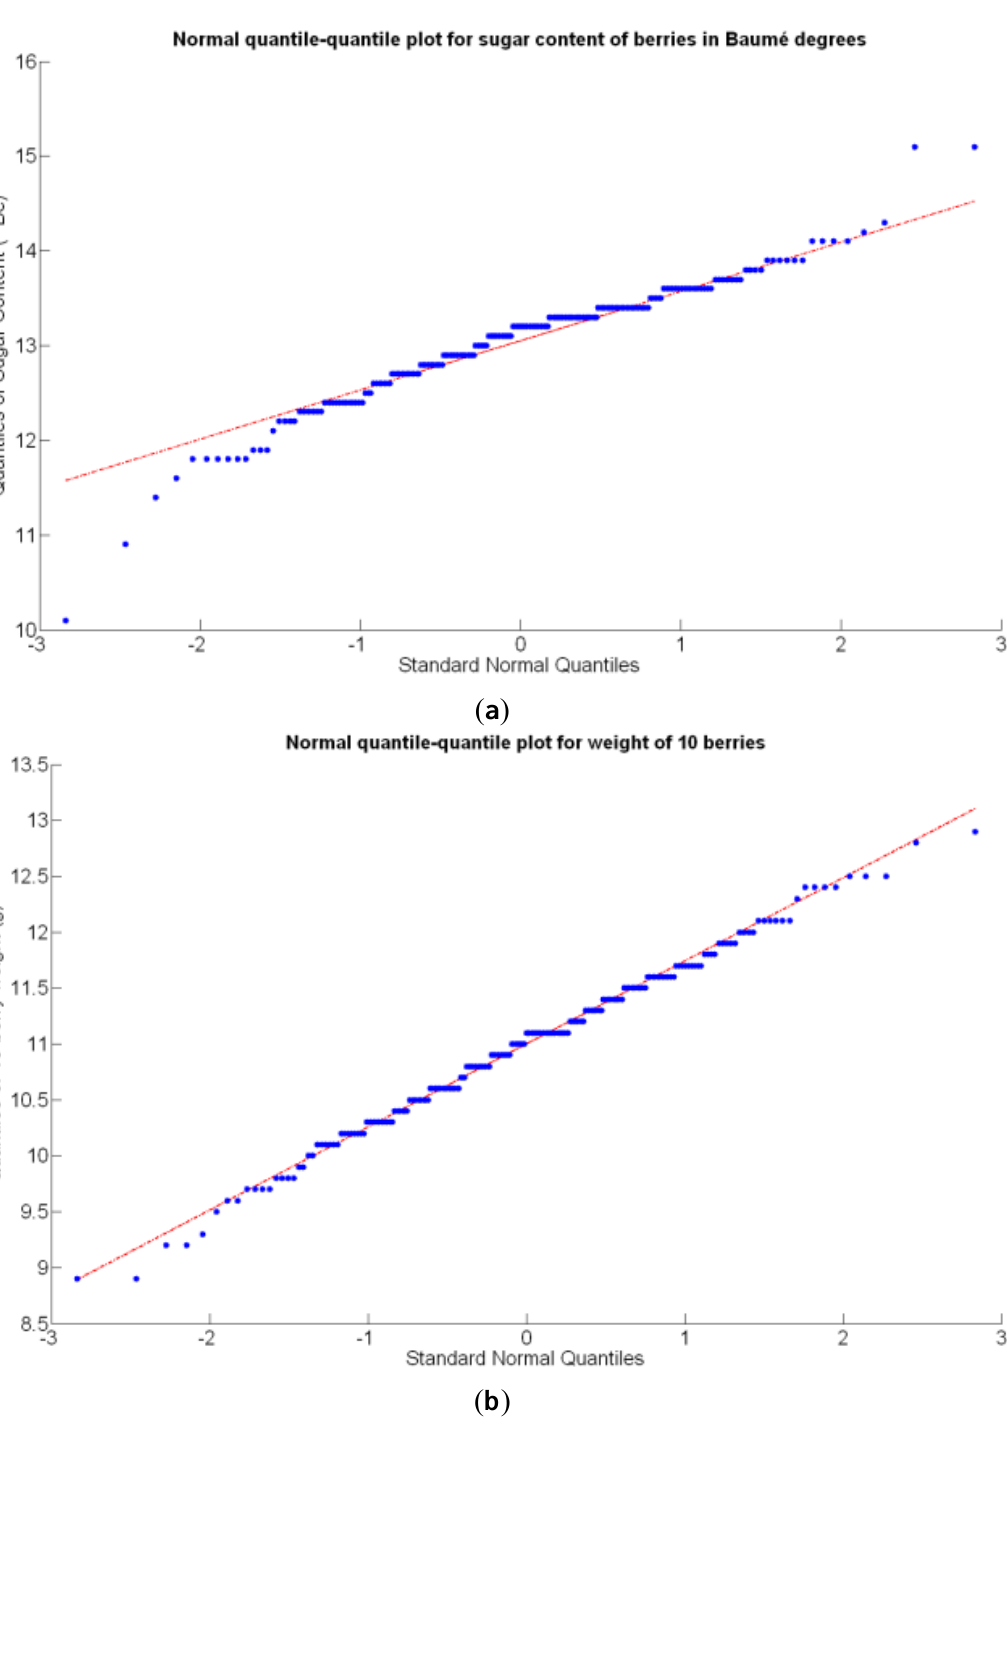
Figure 20. Normal quantile-quantile plots: ( a ) Sugar content in must (º Baumé); ( b ) 10-berry weight